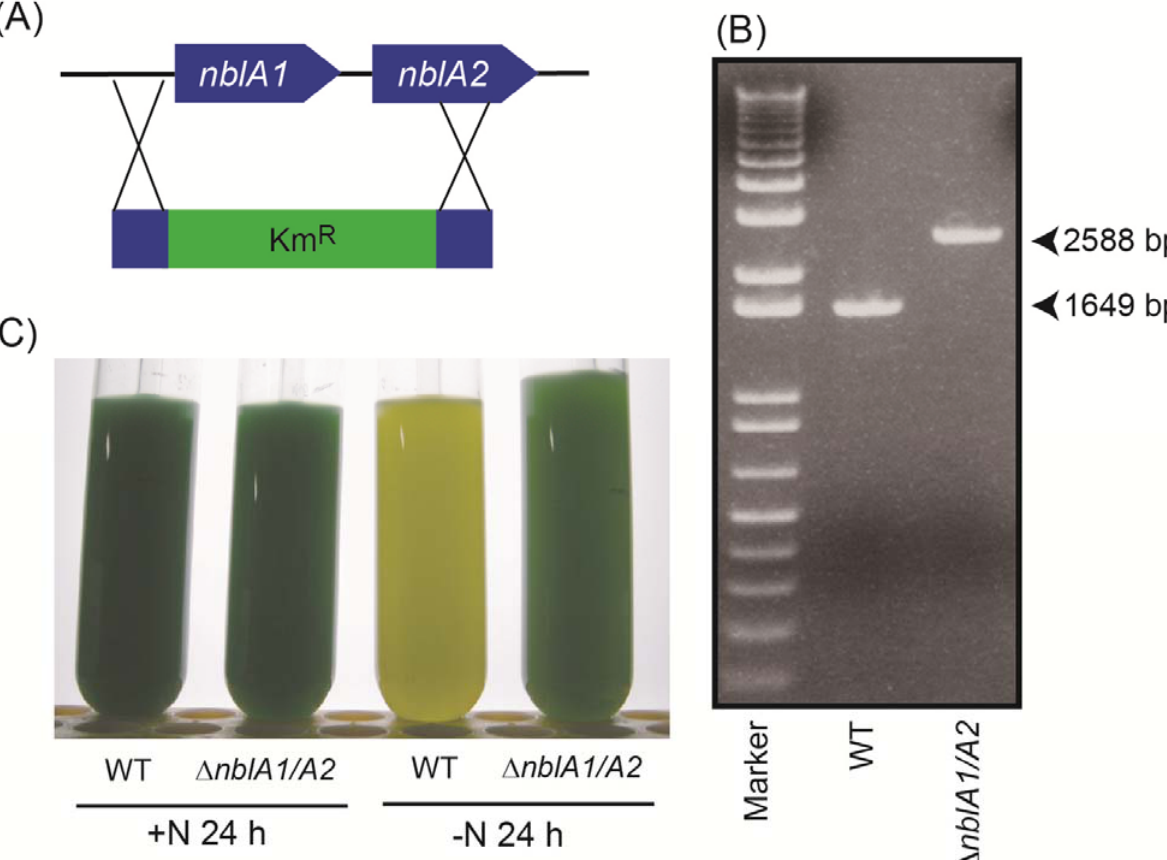
Figure 4. ( a ) Deletion of nblA1/A2 by a kanamycin resistance cassette (Km R ); ( b ) PCR nblA1/A2 mutant ( Δ nblA1/A2 ) and 1649 bp for wild type; ( c ) Non-bleaching phenotype